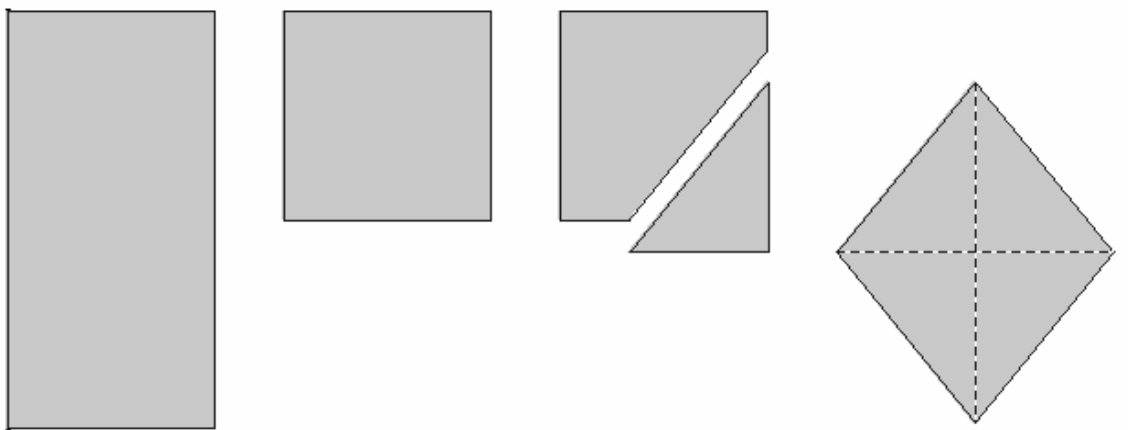
Figure 2. Paper-folding and cutting – a